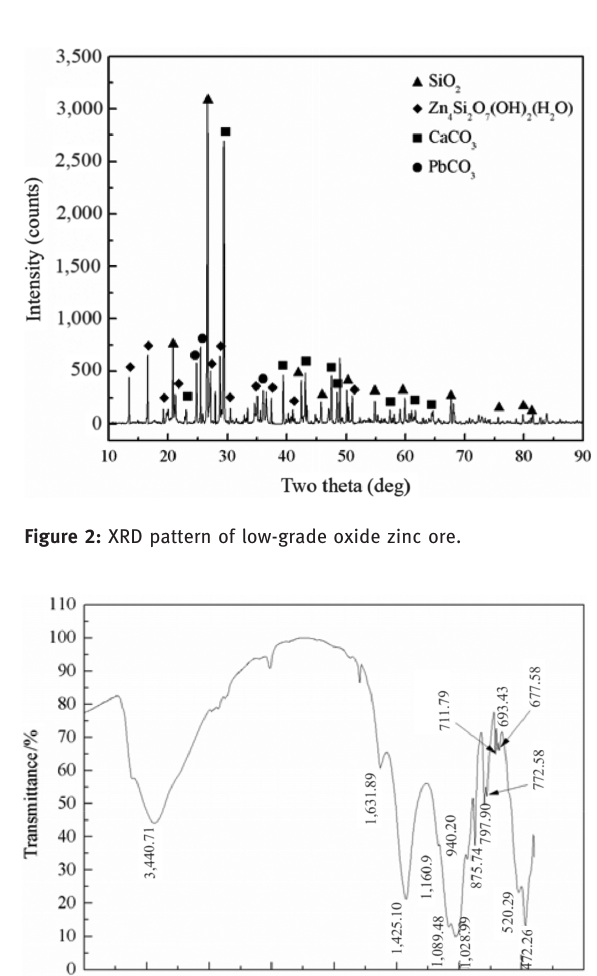
Figure 1: SEM image and EDS pattern of low-grade zinc oxide